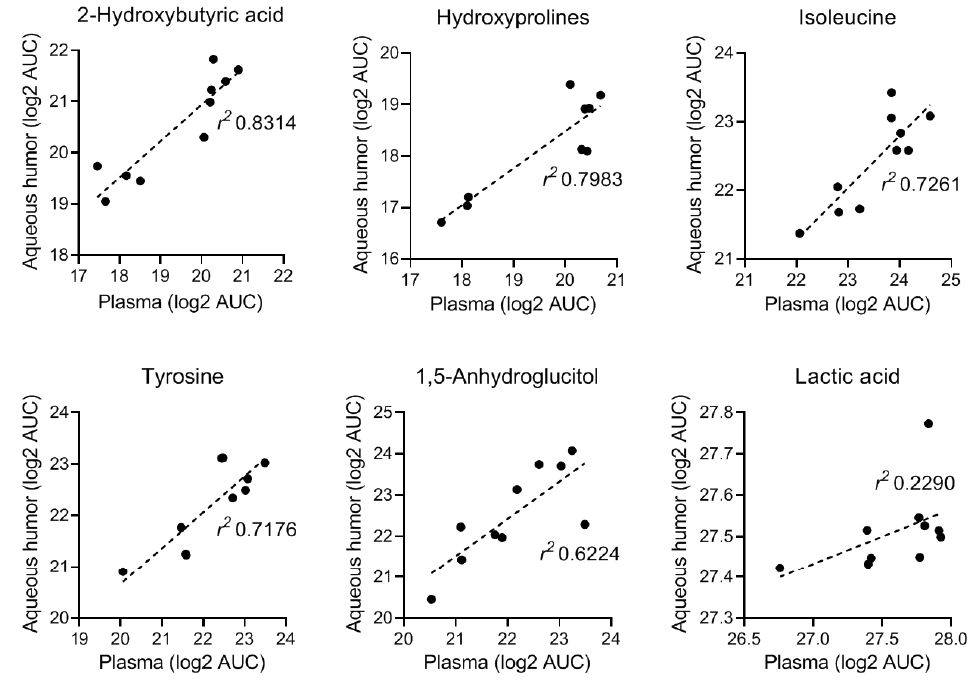
Figure 2. Representative metabolites that showed strong correlation in their aqueous humor and plasma levels as measured by GC-MS. Data shown as log 2 AUC values (arbitrary units) acquired in aqueous humor and plasma samples ( n = 10 each).